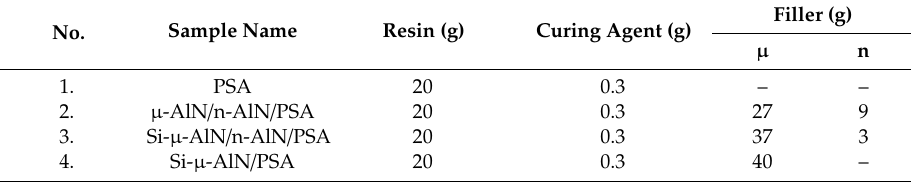
Figure 1. Schematic representation of the synthesis of acrylic pressure-sensitive / aluminum nitride (AlN) composites. Table 1. Composition of different acrylic pressure-sensitive composite samples.